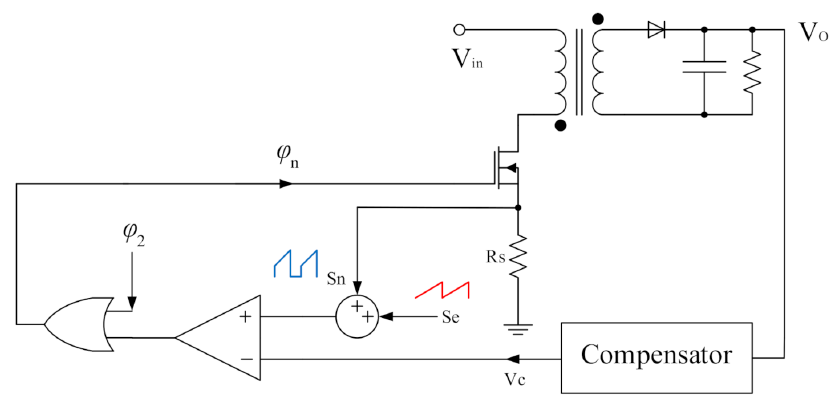
Figure 10. Simplified closed loop model of the flyback converter for the first